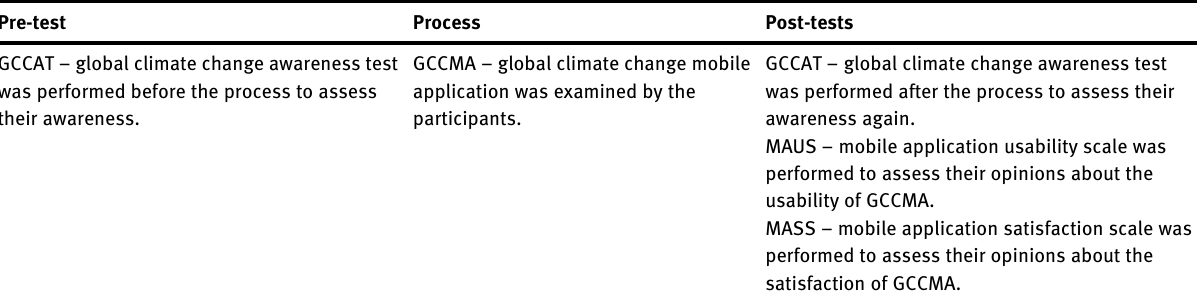
Table  : The study ’ s process.